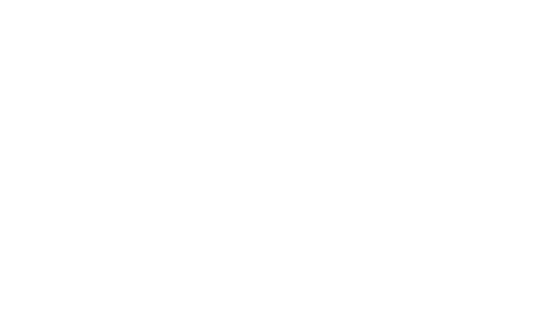
*EHD de fi ned stable disease. ^NR, not reported.